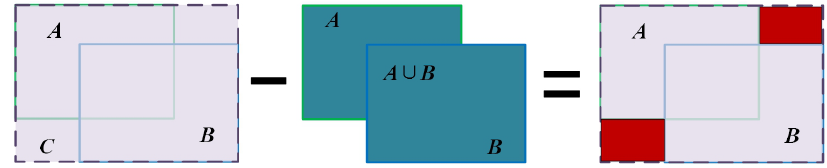
Figure 5. Spatial representation of